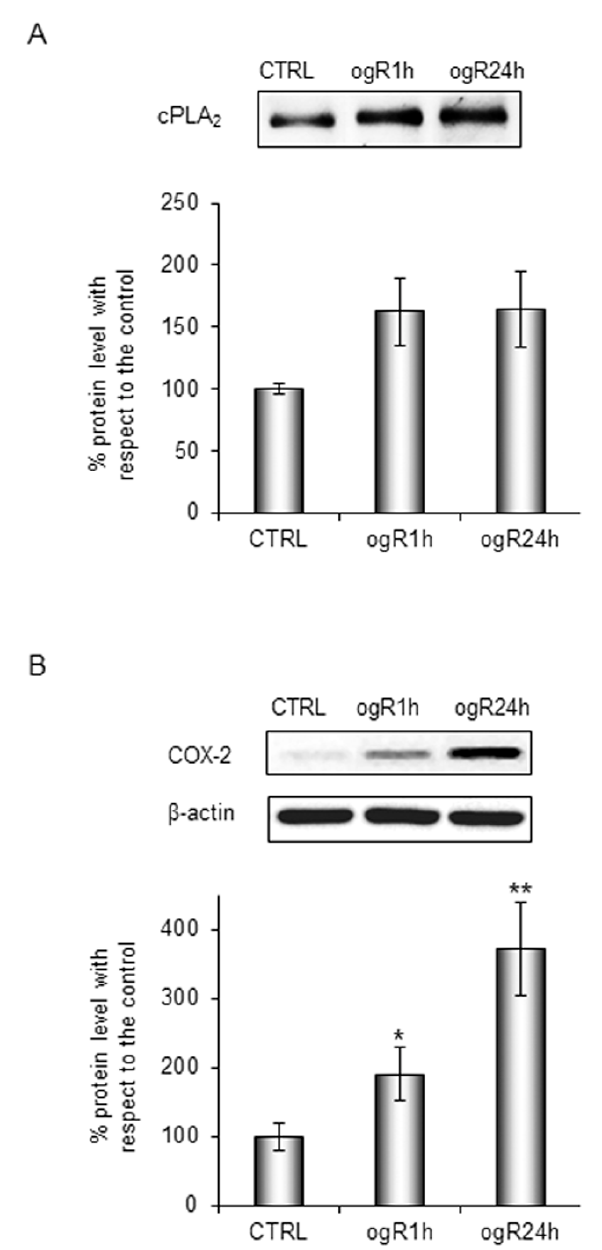
Figure 2. Analysis of proteins involved in arachidonic acid (AA) metabolism in ogR. Cells subjected to OGD treatment were harvested in hypotonic solution at 1 h and 24 h ogR. Total homogenate aliquot was collected and membrane-enriched fractions (MEFs) were obtained by ultracentrifugation. Equal amounts of MEF or homogenate samples (as protein) were subjected to SDS-PAGE and WB analysis. Ponceau staining of total lanes was employed to perform band quantification of MEF samples, while total lysates were normalized by β -actin content. Panel ( A ) represents the % of cPLA2 increment and panel ( B ) the % of COX-2 protein levels with respect to CTRL. The data are expressed as mean ± S.E. from three independent experiments, * p < 0.05, ** p < 0.01 vs. control.